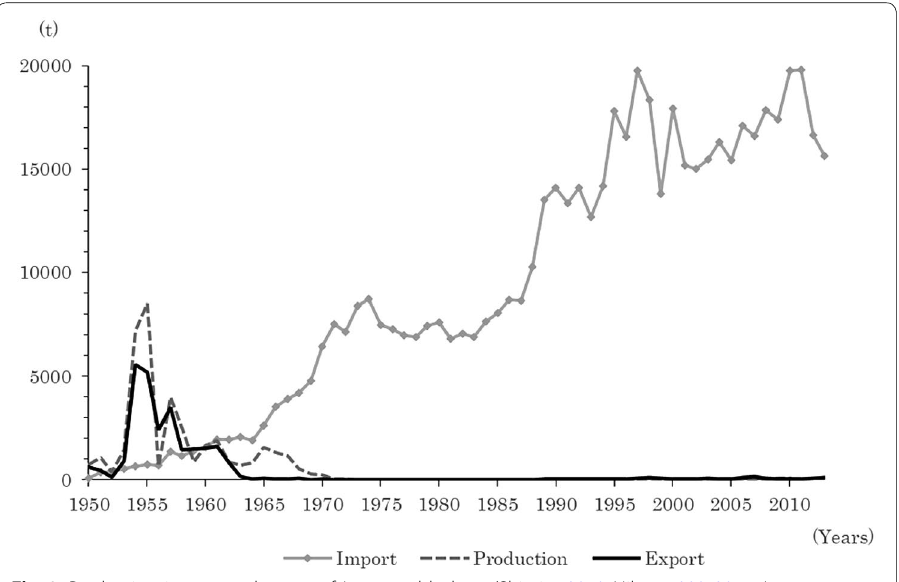
Fig. 2 Production, import, and export of Japanese black tea (Shimizu 2010; Nihon 1990, 2014; Japanese Association of Tea Production